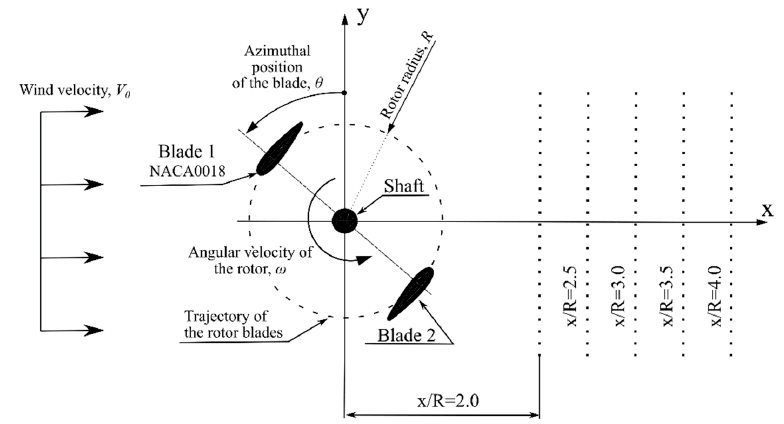
Figure 2. Aerodynamic model of the two-dimensional H-Darrieus wind turbine. Energies 2019 , 12 , x FOR PEER REVIEW